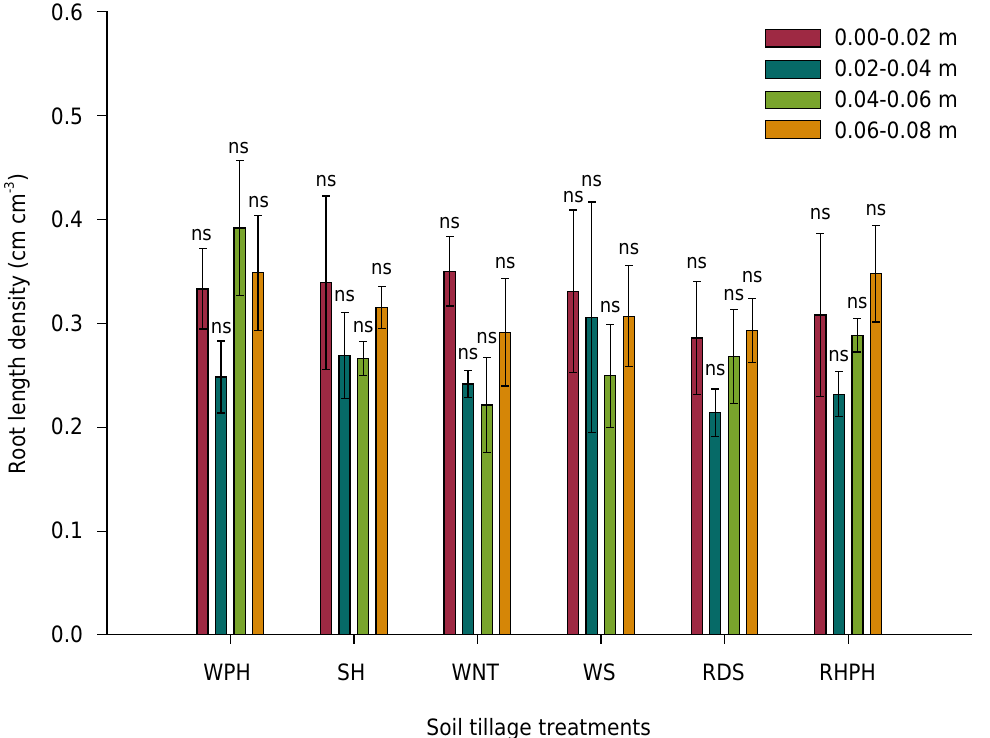
Figure 1. Root length density of sugarcane plants at different layers and under different soil tillage practices. Treatments: WPH = weed desiccation + moldboard plowing (0.4 m) + mild spike tooth harrowing (0.15 m); SH = subsoiler (0.3 m) + mild spike tooth harrowing (0.15 m); WNT = weed desiccation + no-tillage (only furrow opening); WS = weed desiccation + subsoiler (0.4 m); RDS = ratoon destruction + subsoiler (0.40 m); RHPH = ratoon destruction + spike tooth harrowing (0.2 m) + moldboard plowing (0.4 m) + mild spike tooth harrowing (0.15 m). ns = not significant differences among soil tillage treatments at each soil layer by Tukey’s test at 1 % significance. CV = 32.72